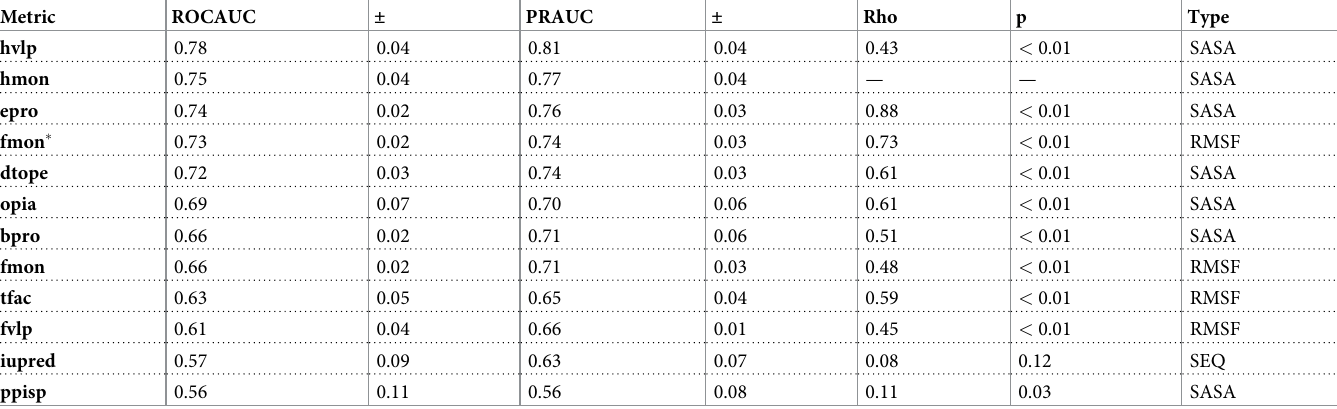
Metrics are ordered from the top to bottom in terms of highest ROCAUC and PRAUC product. Spearman rho (r) and p-values are shown for associations between isolated protein convex hull scores (hmon) vs. VLP protein convex hull scores (hvlp), partially isolated protein RMSF (fmon � ), DiscoTope scores (dtope), Epitopia scores (opia), ElliPro scores (epro), BEpro scores (bpro), isolated protein RMSF (fmon), VLP protein RMSF (fvlp), temperature factors (tfac), cons-PPISP scores (ppisp), and IUPred scores (iupred). The primary type of structural information utilized for each metric is shown under the heading titled Type (solvent accessible surface area (SASA), protein flexibility (RMSF), and sequence information